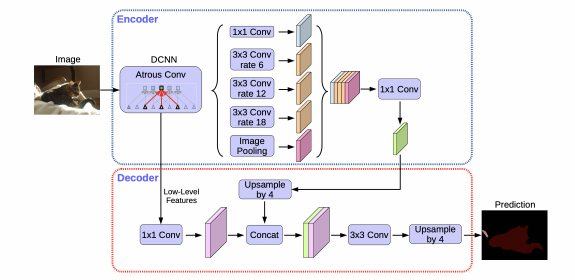
Figure 2. DeepLab v3+ architecture, image credits to (Chen et al., 2018).